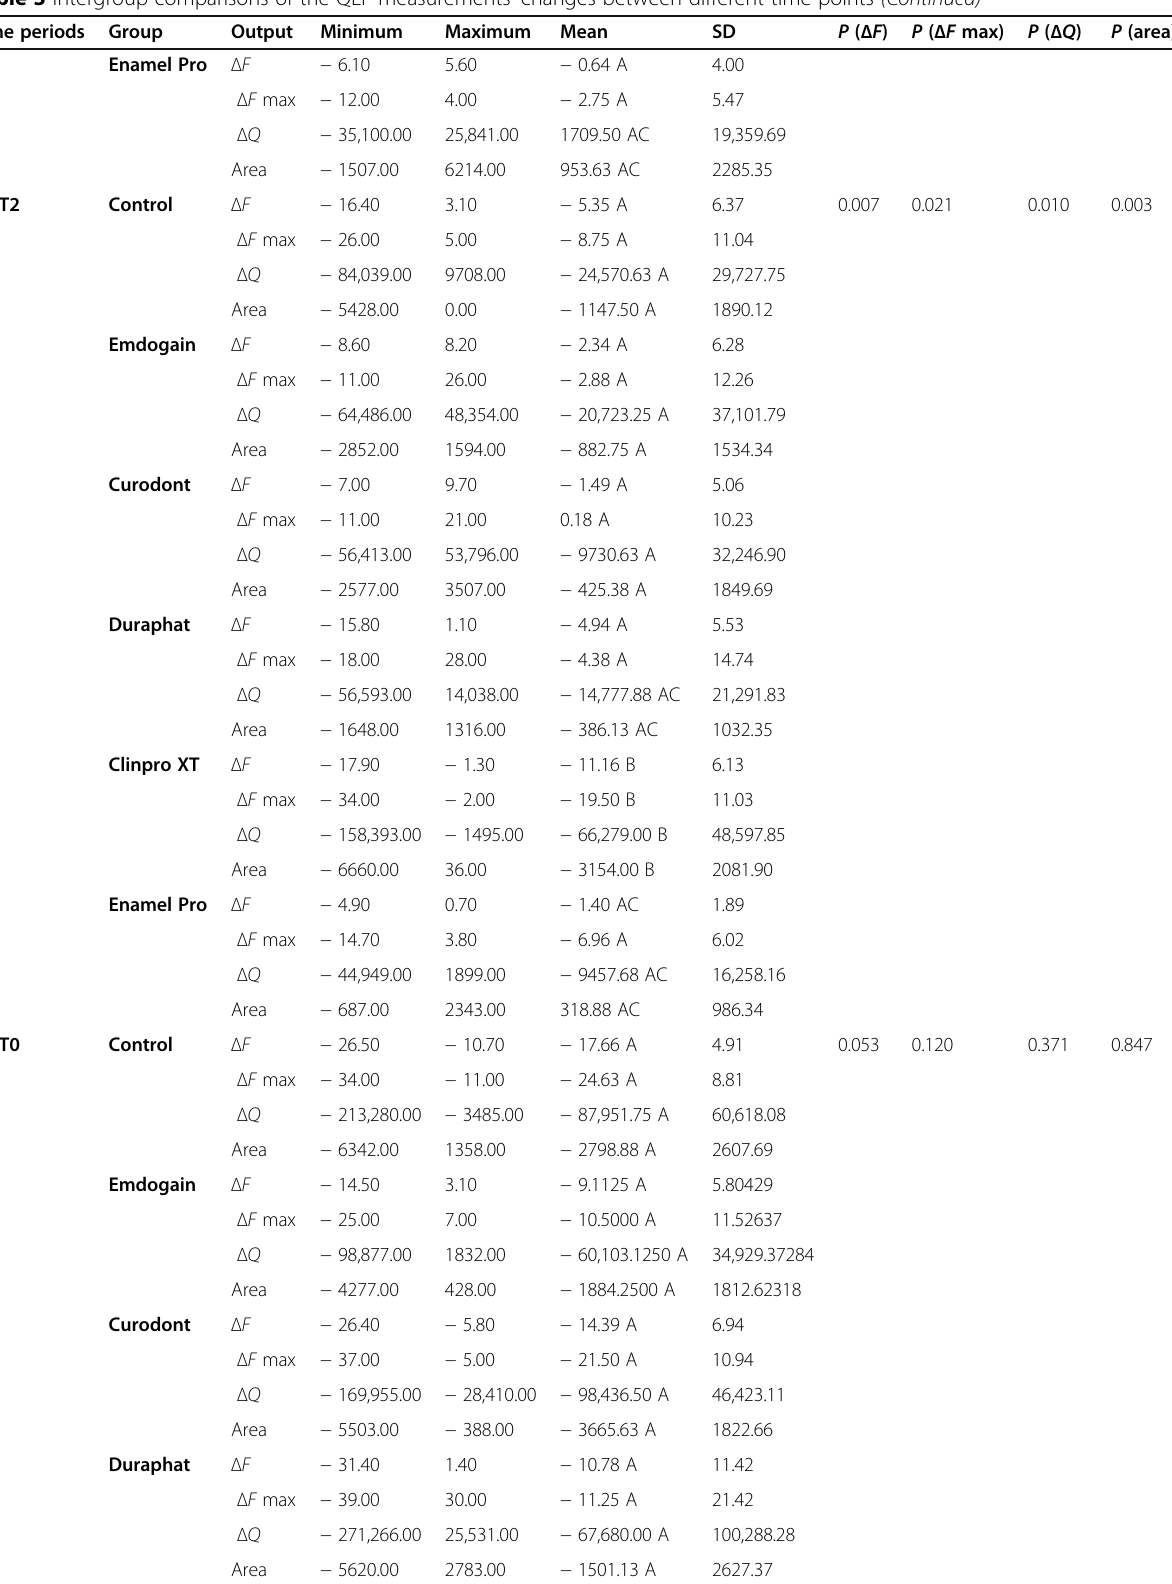
Table 3 Intergroup comparisons of the QLF measurements ’ changes between different time points (Continued) Time periods